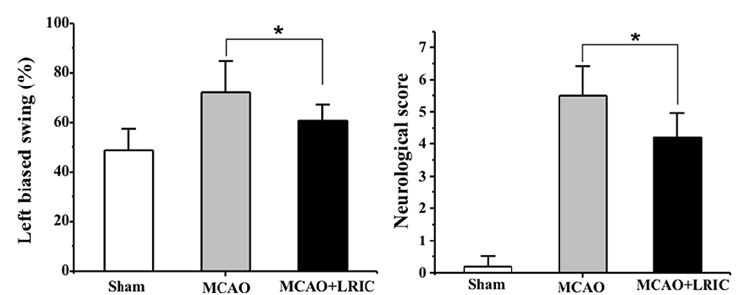
Figure 2. Effects of LRIC on neurobehavioral function after focal ischemia. The elevation body swing test (the higher the percentage, the more severe the defect) and the neurobehavioral scoring system were used to score the neurological impairment. * p < 0.05, N = 10 per group.